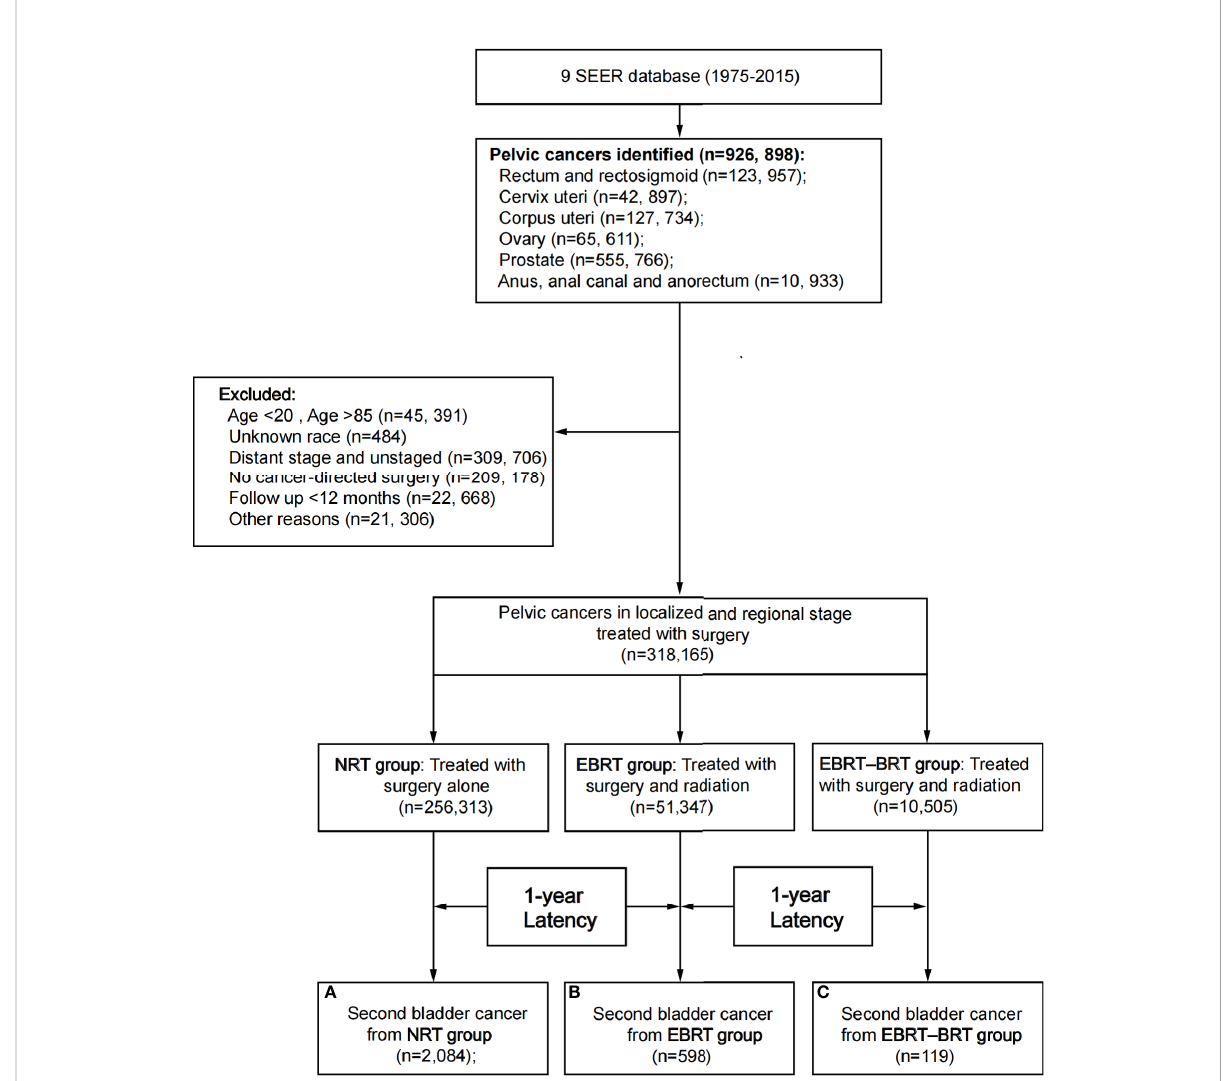
FIGURE 1 Flow diagram. SEER, Surveillance, Epidemiology and End Results; RT, radiation therapy; NRT, no radiation therapy; EBRT, external beam radiation therapy; EBRT – BRT, external beam radiation therapy with brachytherapy involving implants or